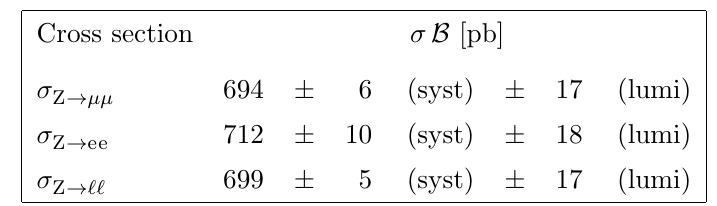
Table 3 . The measured inclusive (cid:12)ducial cross sections in the dimuon and dielectron (cid:12)nal states. The combined measurement is also shown. B is the Z ! ‘‘ branching